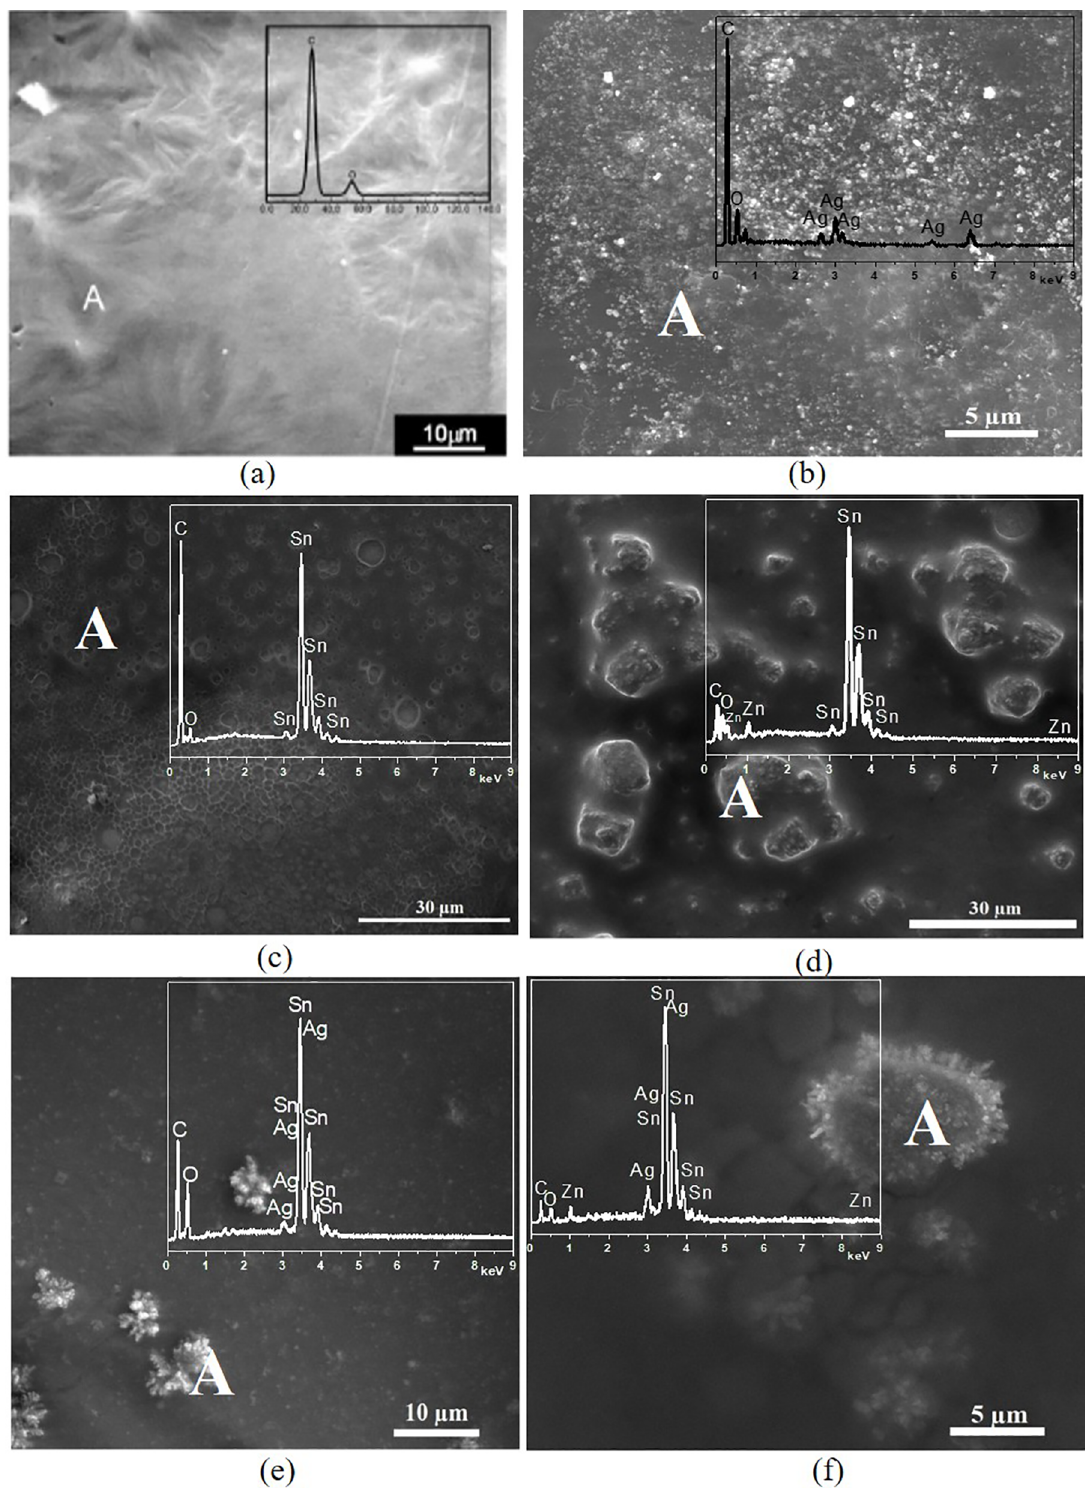
Figure 2. Micrographs obtained by Scanning Electron Microscopy and EDS spectra obtained at the point A: (a) PCL film 17 ; (b) PCL+NPAg- ribbon; (c) Sn+PCL-ribbon; (d) Sn3Zn+PCL-ribbon; (e)Sn+PCL+NPAg-ribbon; (f)